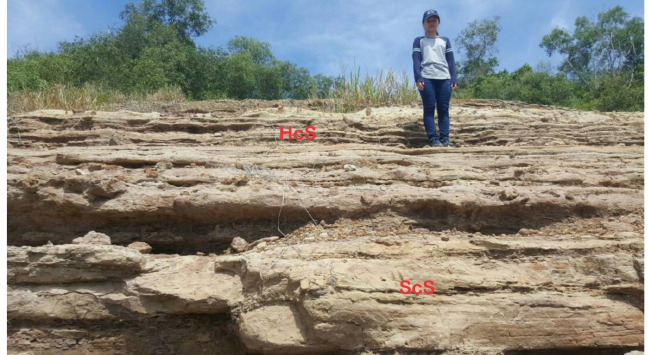
Figure 5: The swaley-hummocky cross stratified is overlying another. It is showing that the swaley cross stratified is overlain by hummocky cross stratified. 4.6 Facies 4: Hummocky cross stratified